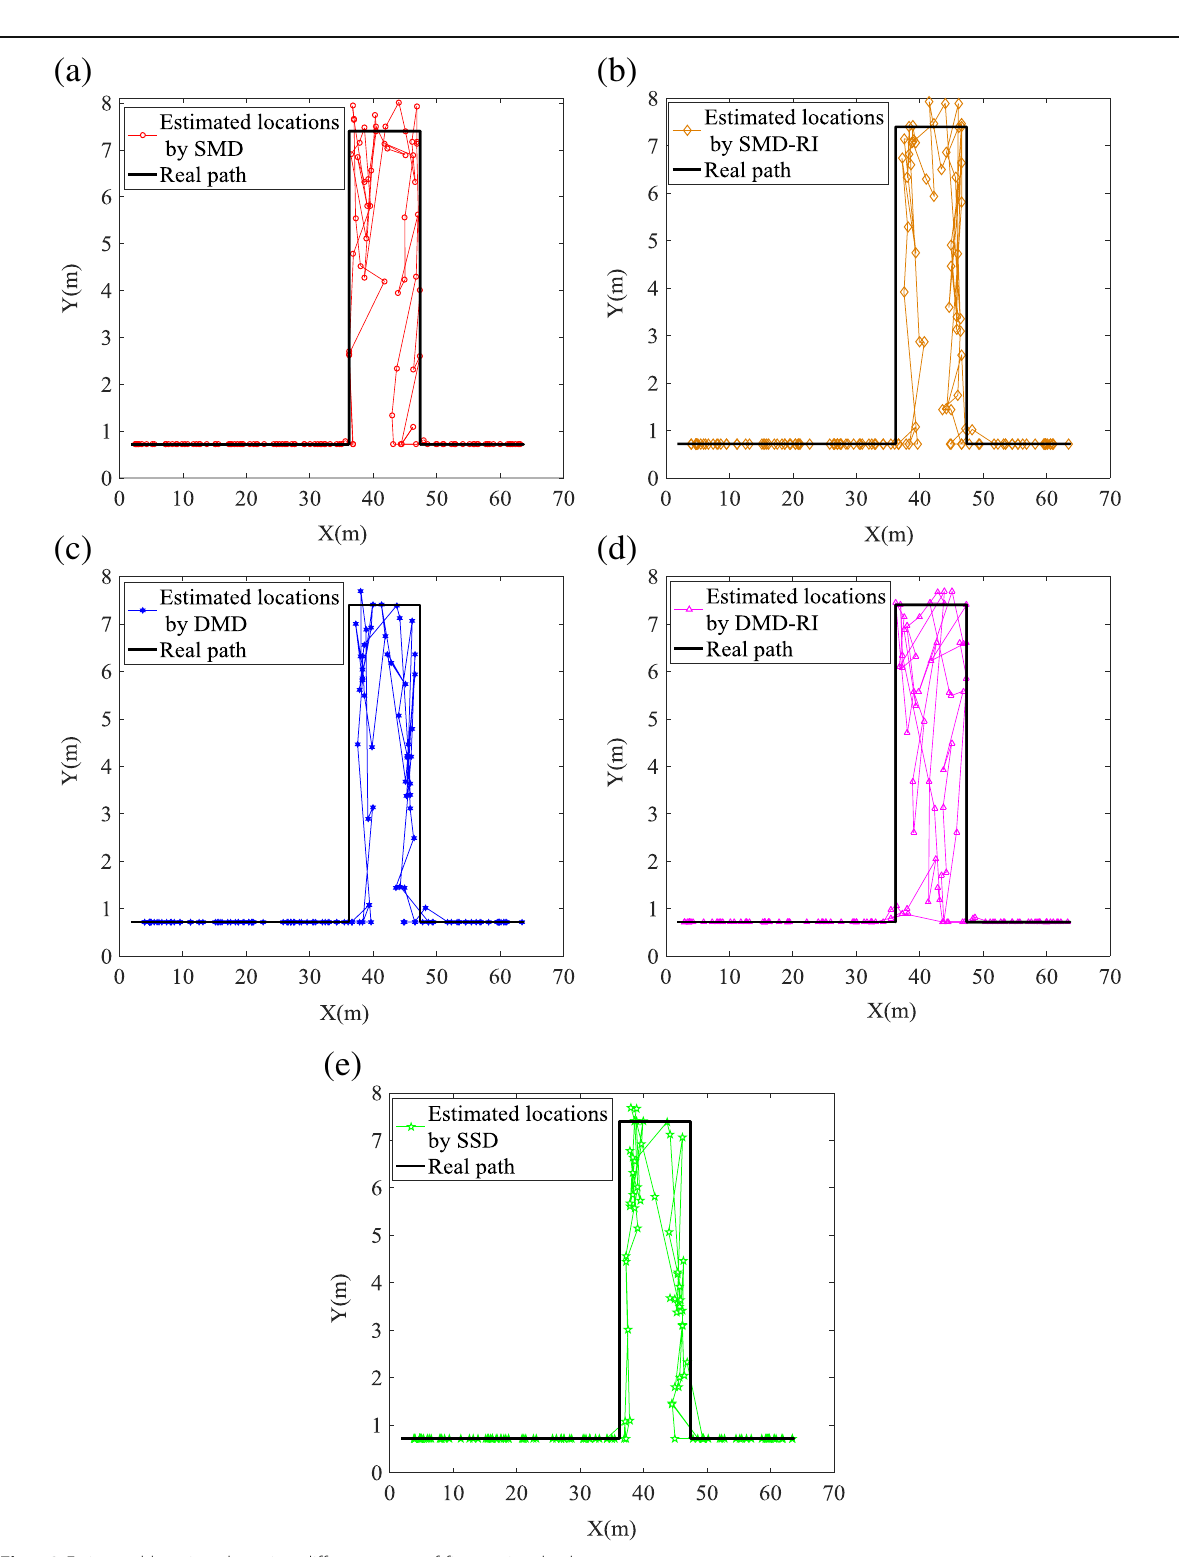
Fig. 13 Estimated locations by using different types of fingerprint